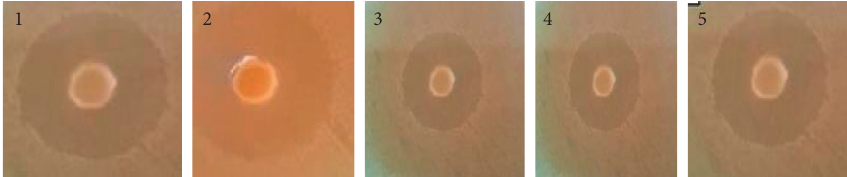
Figure 11: Antimicrobial activity (inhibition zones in mm) of Al-GIC (group V) against the investigated microorganisms.